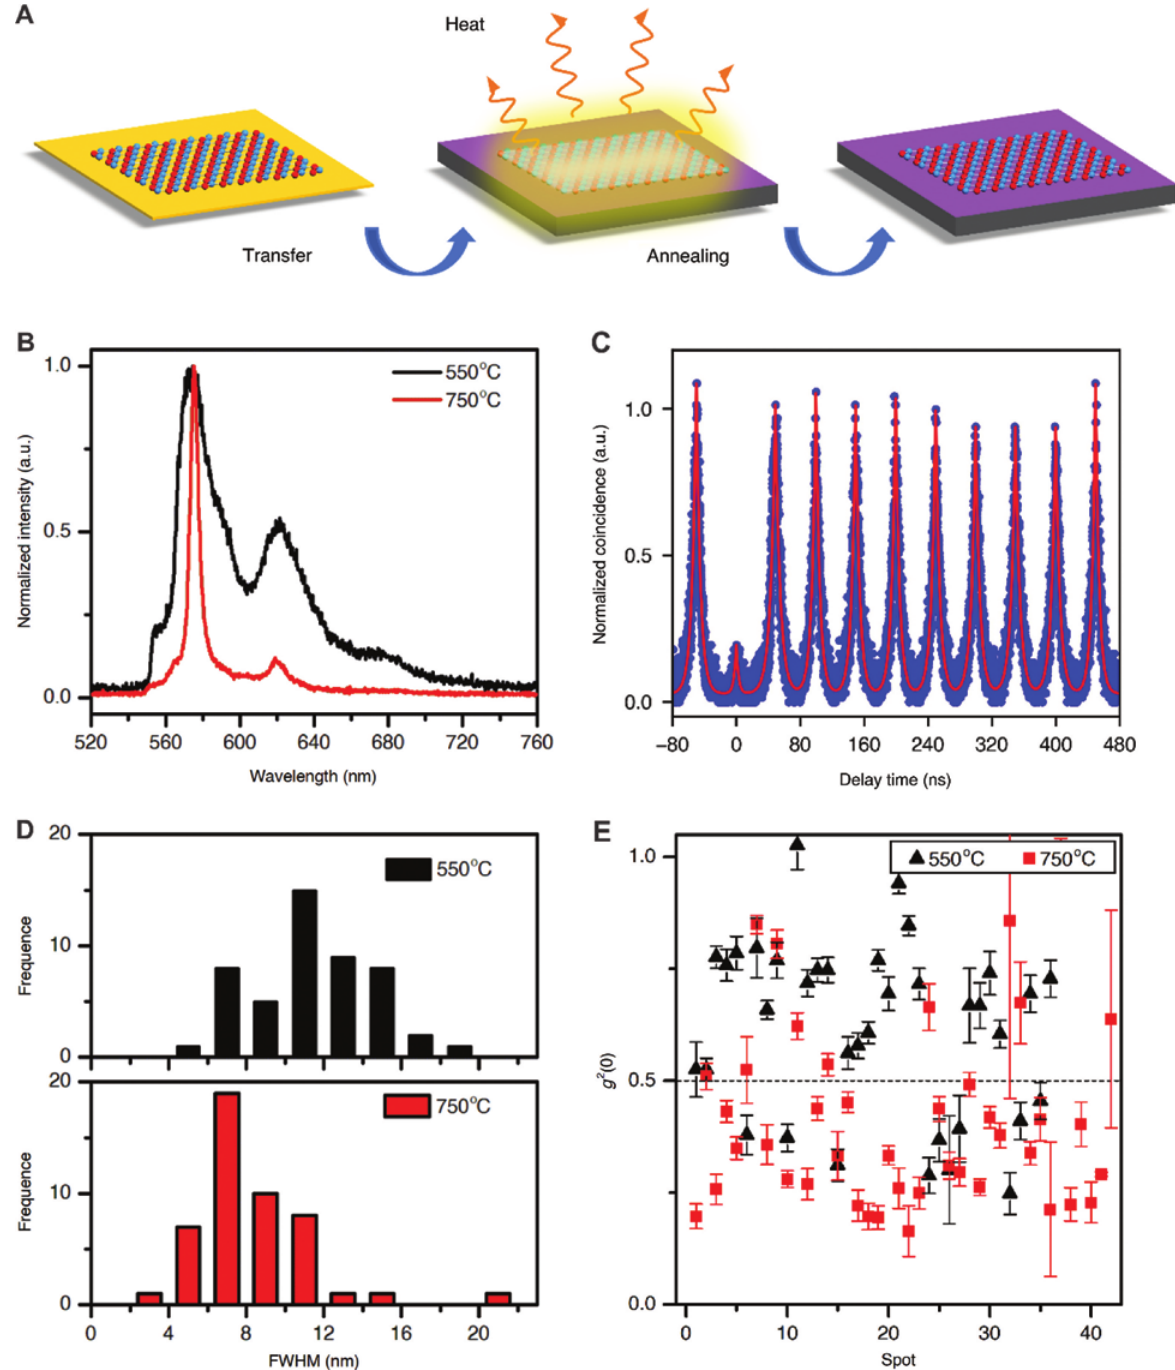
Figure 1: Room-temperature optical characterizations of annealed CVD hBN films. (A) Schematic illustration of the thermal annealing process. hBN films were transferred from copper substrates to Si/SiO substrates and subsequently annealed at high temperatures prior to optical measurements. (B) Normalized PL spectra of a representative SPE from hBN annealed at 550 ° C (black) and 750 ° C (red). The ZPLs have an FWHM of ~ 18.0 and 4.0 nm, respectively. (C) Autocorrelation curve obtained from an emitter that was annealed at 750 ° C. The excitation source was a 20-MHz, 512-nm pulsed laser. The intensity at zero delay time [ g 2 (0)] is 0.07 ± 0.03 (without background correction) at room temperature. Red curve is fitted data by single exponential decay function. (D) Histograms of the FWHM of SPE emission lines from hBN samples annealed at 550 ° C (red) and 750 ° C (black). The average FWHM are 11.9 and 8.1 nm, respectively. (E) Scatter plot of g 2 (0) values from emitters from corresponding samples shown in (D). Average g 2 (0) values are 0.62 ± 0.19 and 0.41 ± 0.20 for hBN-550 and hBN-750,